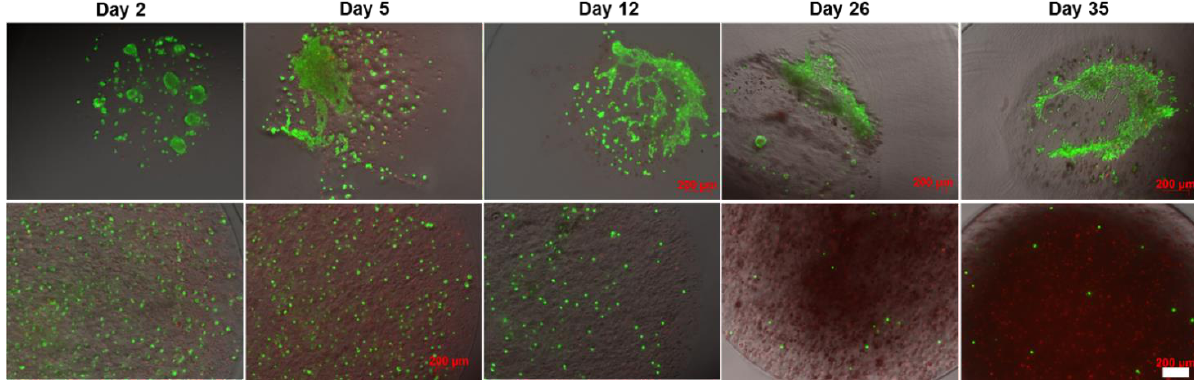
Figure 4. Representative fluorescent images of cj aMSCs encapsulated in core-shell capsules ( upper row ) and solid beads ( lower row ) for a total period of 35 days in culture. Scale bars are 200 µm.